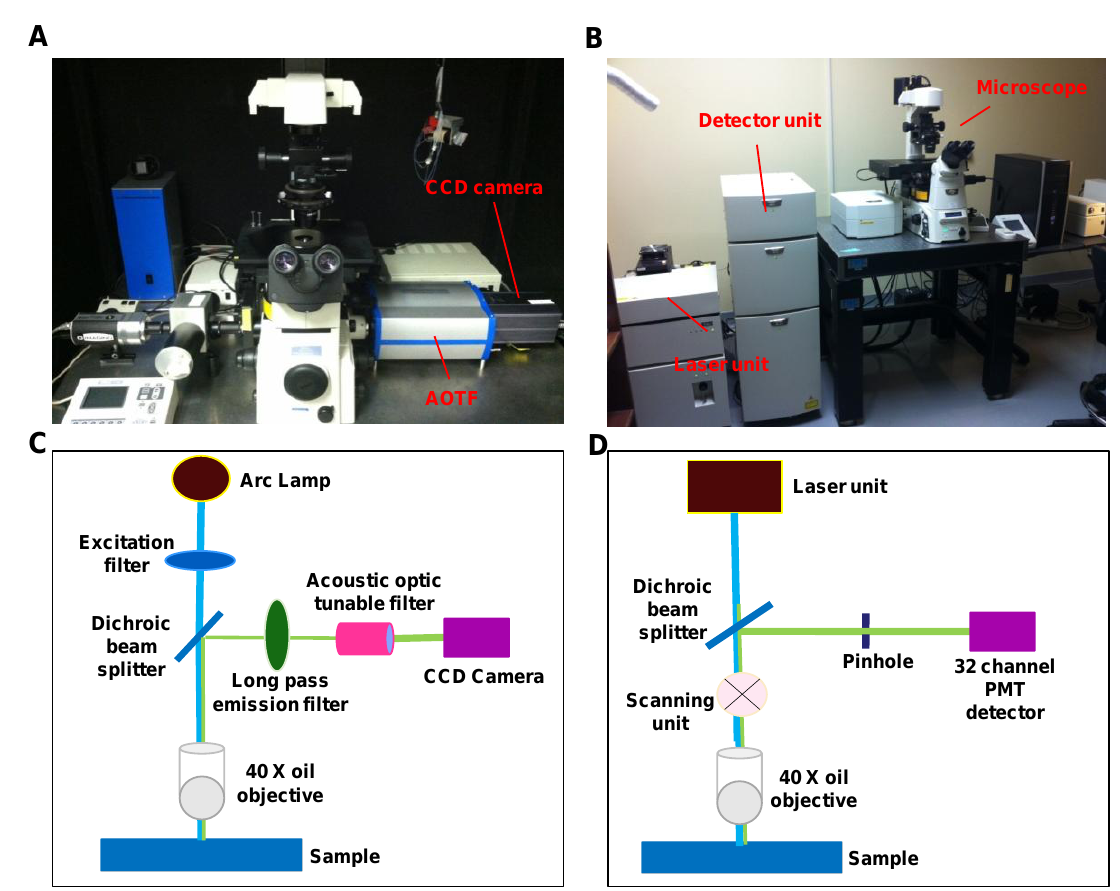
Figure 1. Photographs and light path of the hyperspectral imaging systems used in this study. ( A ) hyperspectral widefield fluorescence microscope; ( B ) hyperspectral confocal fluorescence microscope; ( C ) schematic describing the light path in the widefield system; ( D ) schematic describing the light path in the confocal